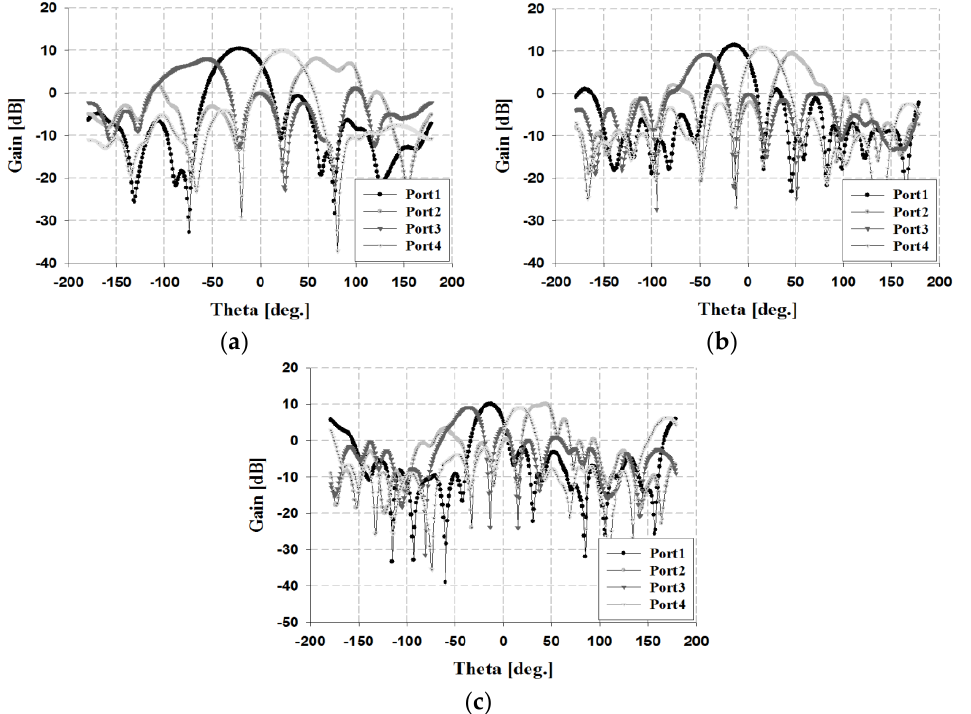
Figure 26. Measured results of the fabricated phased array antenna at each frequency: ( a ) 3, ( b ) 4, and ( c ) 5 GHz.